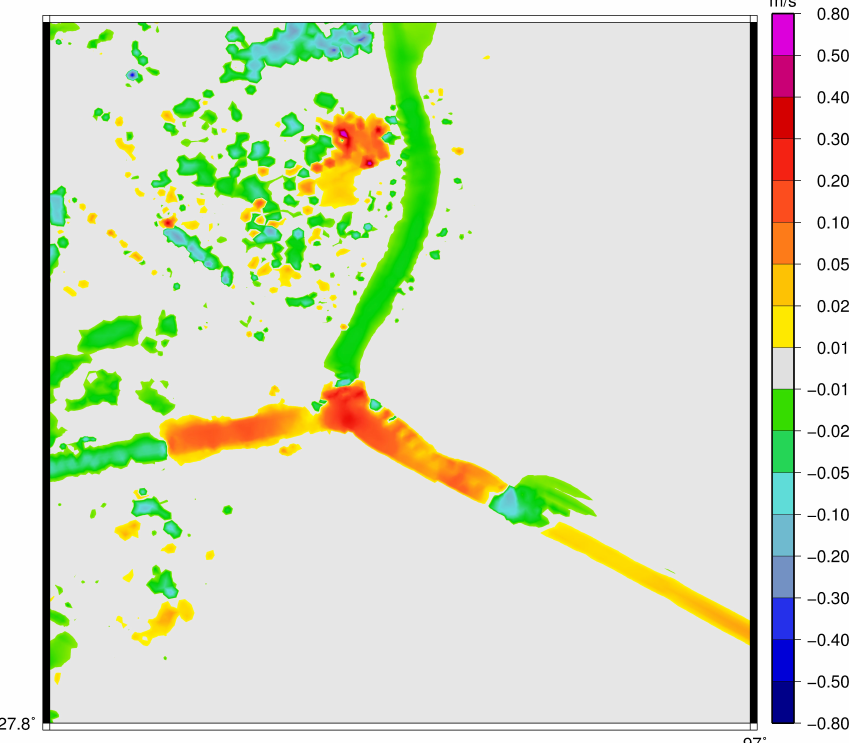
Figure 13. Difference in maximum velocity component with 2012 forcing.